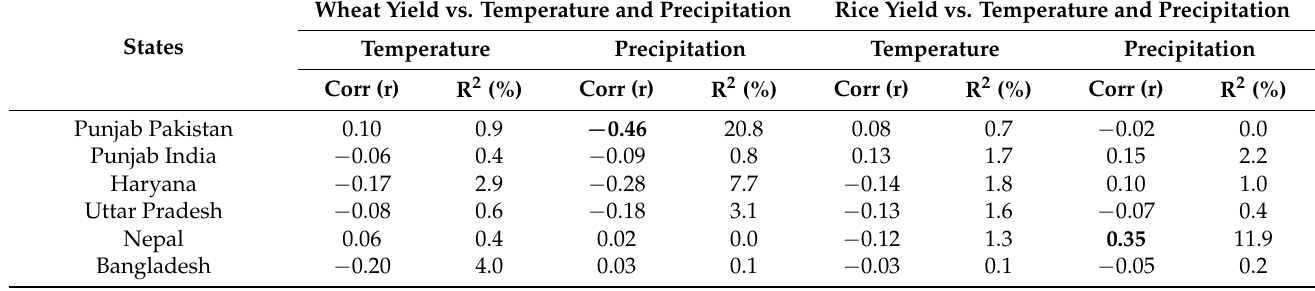
Table 3. Correlation coefficient (r) and Coefficient of determination (R 2 ) in % calculated between observed wheat and rice yields based on PBS yields with observed temperature and precipitation in five major wheat and rice producing districts in Punjab Pakistan during 1982–2009 period. Bold numbers show the strong correlation, i.e., more than 0.30 between crop yields with climate variables and star shows the statistically significance level. Wheat Yield vs. Temperature and Precipitation Rice Yield vs. Temperature and Precipitation Districts Temperature Precipitation